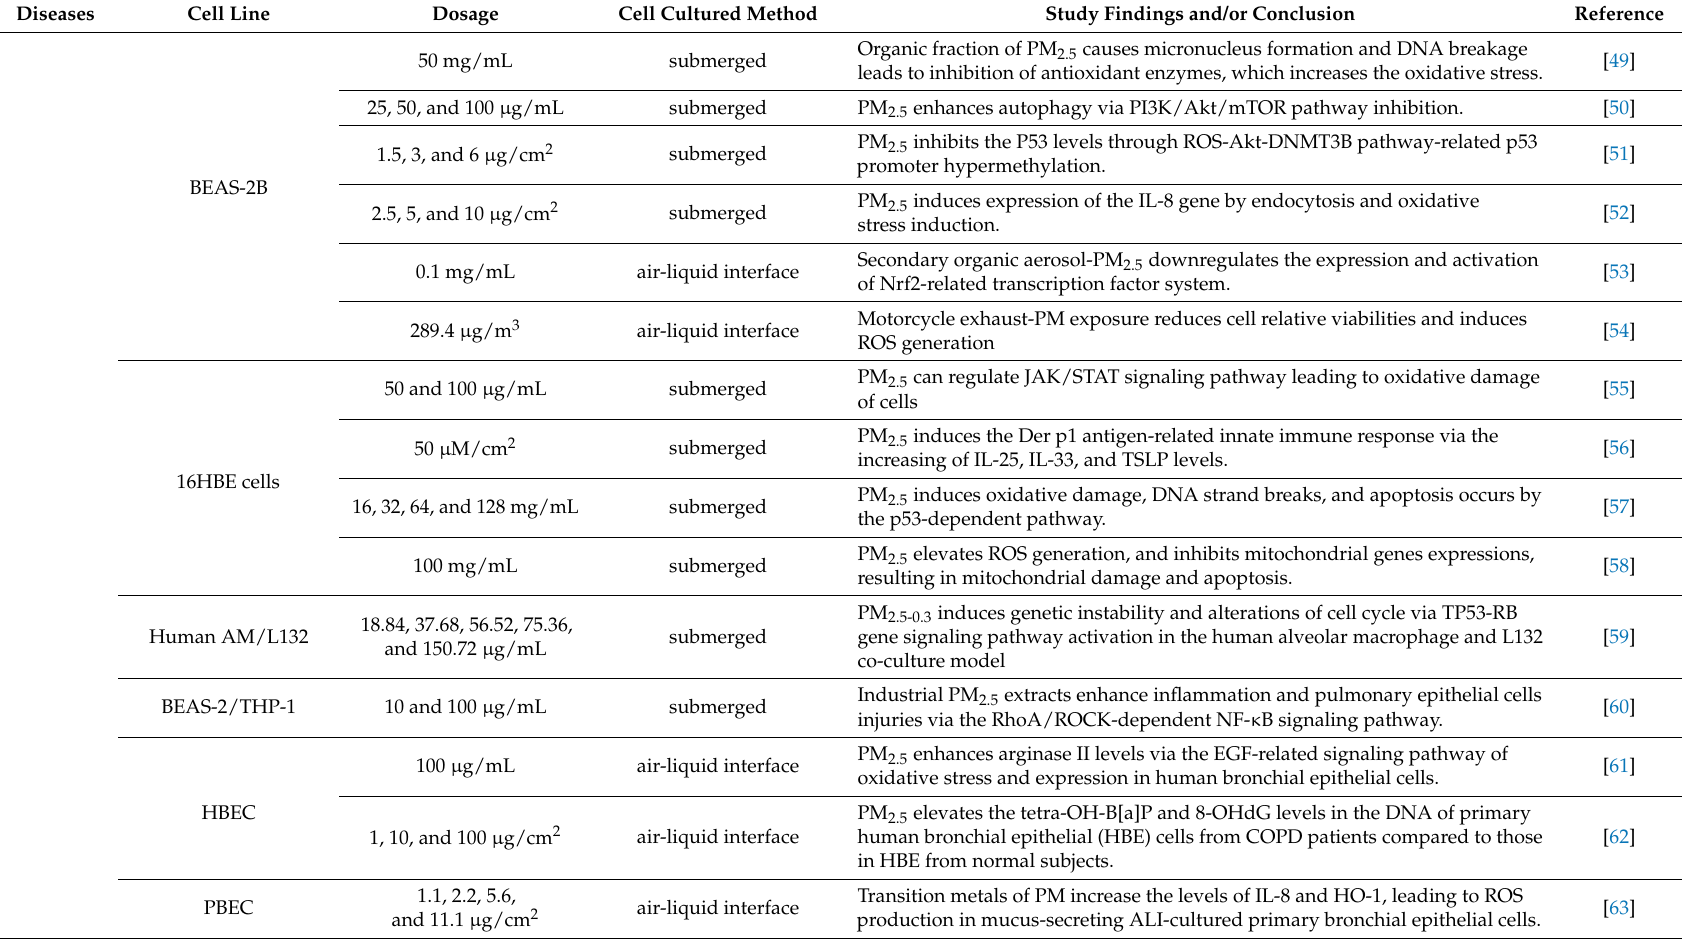
Table 1. Summary of in vitro studies for the effects of PM 2.5 treatment on cell responses and